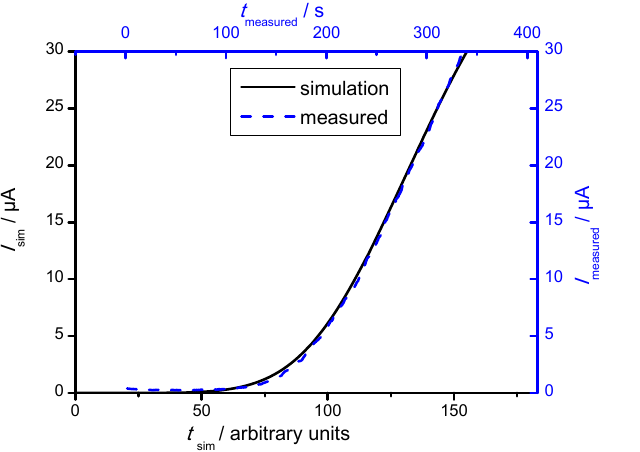
Figure 3. Simulation and real measurement of soot signal for a blank sensor